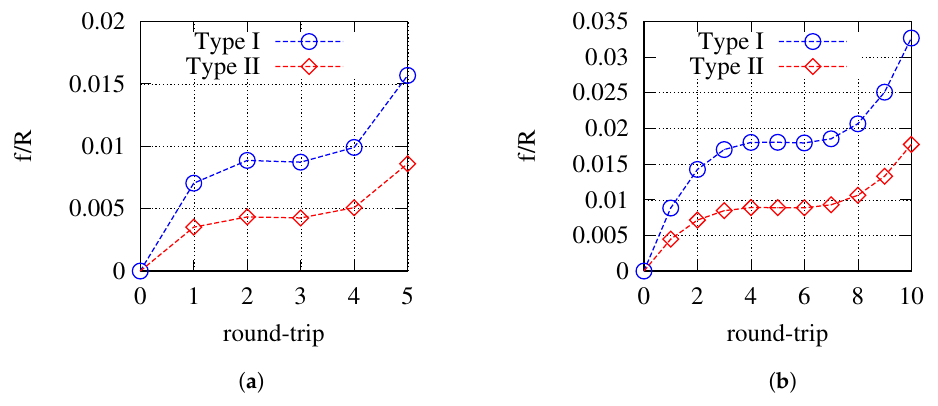
Figure 9. Evolution of the astigmatic deformation of the wavefront for 5 round-trips ( a ) and for 10 round-trips ( b ). Lines are only for illustration